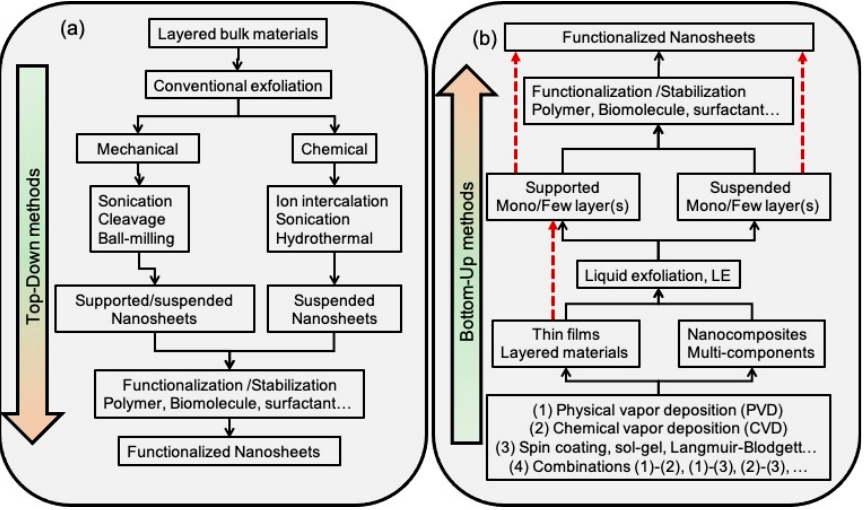
Figure 5. Scheme summarizing the bottom-up ( a ) and top-down ( b ) methods for the production of functionalized NSHs. With emphasis on inorganic, hybrid organic–inorganic, and Janus hybrid